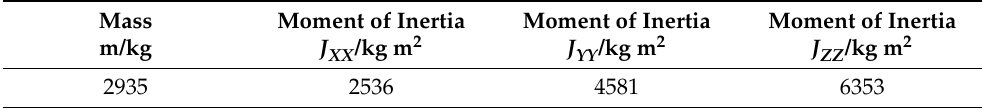
Figure 3. Sketch and force diagram of test line with SCM coils and ground coils at the CRRC: ( a ) cross section; ( b ) vertical view; ( c ) eight levitation forces. With the inertial reference o xyz − , the origin is in the middle of the plane defined by the figure-eight-shaped coils; the i direction of the longitudinal position x is along the track; the k direction of the vertical position z is downward as the direction of gravity of the acceleration; and the j direction of the lateral position y is defined by = j k i . The ground figure-eight-shaped coils are equally spaced along both sides of the track with a pole pitch of 0.36 m pitch = . The locations of the left figure-eight-shaped coils and the right figure-eight-shaped coils satisfy Equations (1) and (2): 0 (figure-eight-shaped coilson left side) y (1) left_figure_8 0 (figure-eight-shaped coilson right side) y y z = = (2) where y and y are the lateral positions of the left figure-eight-shaped left_figure_8 right_figure_8 coils and the right figure-eight-shaped coils, respectively; z and z are left_figure_8 right_figure_8 the vertical positions of the left and right figure-eight-shaped coils, respectively; and y 0 is the constant. The body coordinate system O XYZ − fixed on the vehicle is defined by the follow- ing method. First, each base vector of the body coordinate system is initially parallel with the corresponding base vector of the inertia reference. The origin of the body coordinate system is not at the center of gravity (C.G), but rather it is at the geometric center of the plane, defined by the center lines of the SCMs on both sides of the vehicle, as shown in Figure 3. The reason is that when plane O XY − coincides with plane o sy − , there is no Table 1. Inertial parameters of the magnetic force when the vehicle is moving forward.